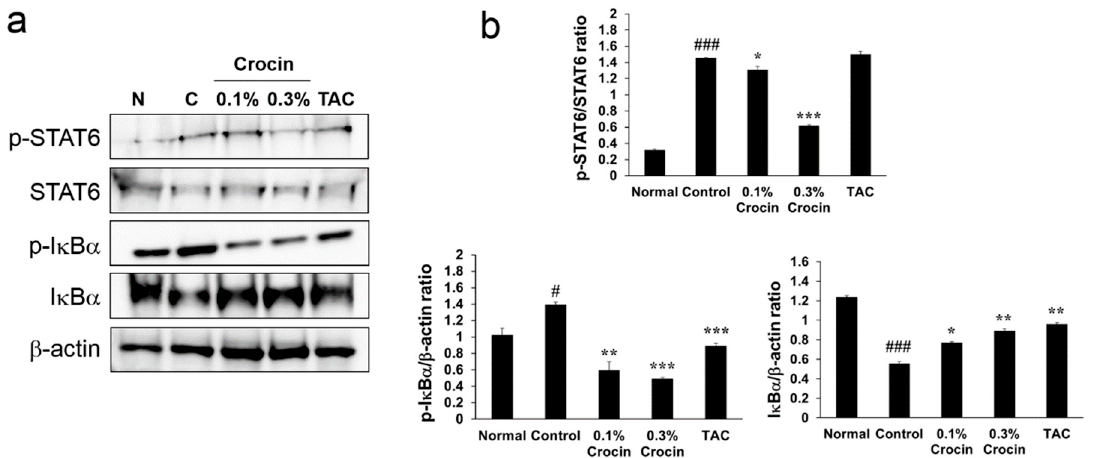
Figure 4. Effects of crocin on Dermatophagoides farinae extract (DfE)-induced NF- κ B and signal transducer and activator of transcription 6 (STAT6) activation in the back skin tissues. Expression of I κ B α , p-I κ B α , p-STAT6, STAT6, and β -actin protein were evaluated by measuring protein levels in the total extracts using Western blotting ( a ). The relative abundance of proteins was calculated for the p-STAT6/STAT6, p-I κ B α / β -actin, and I κ B α / β -actin ratios ( b ). Values represent the mean ± standard error of the mean (S.E.M) of three independent experiments. # p < 0.05 and ### p < 0.001 versus Normal group; * p < 0.05, ** p < 0.01 and *** p < 0.001 versus Control group.